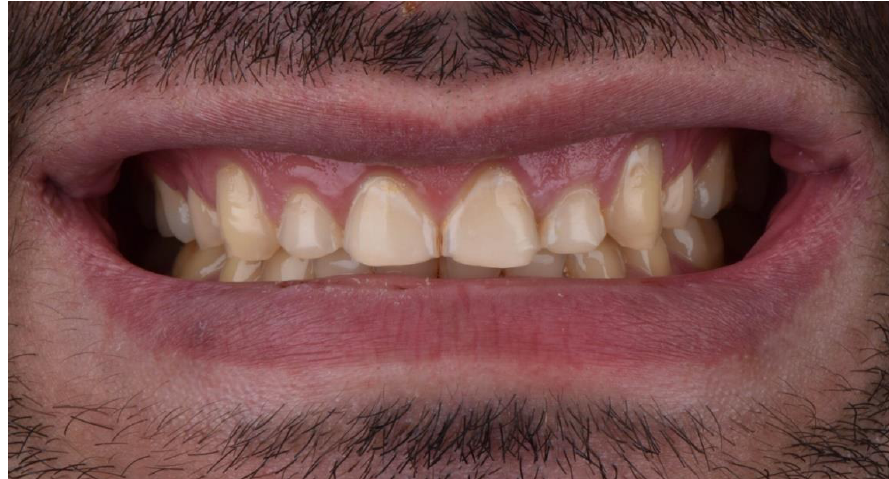
Figure 2. Extraoral smile picture (front).